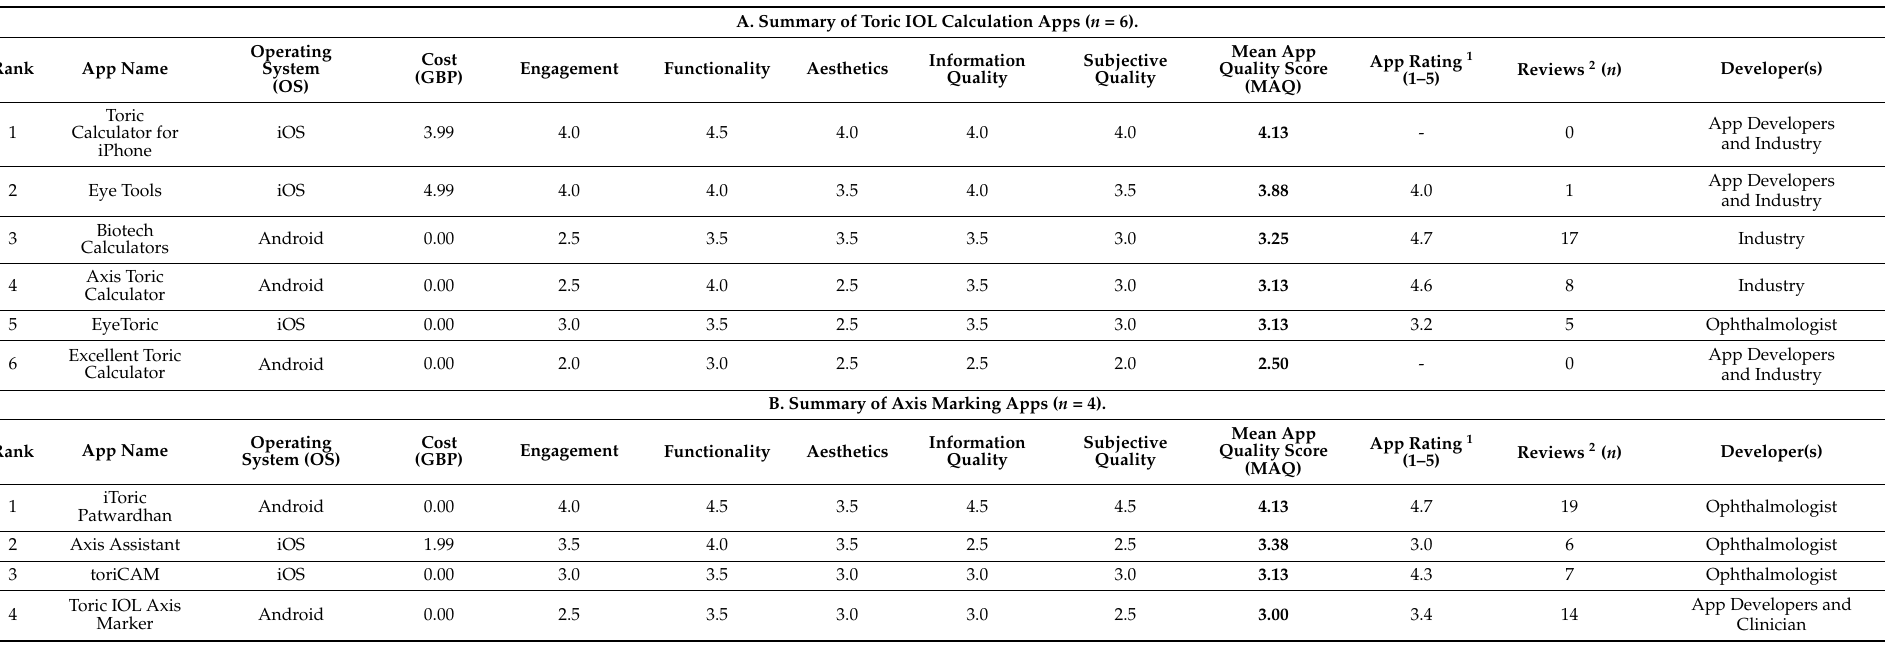
Table 3. Summary of toric IOL calculation apps ( n = 6) and summary of axis marking apps ( n = 4). A. Summary of Toric IOL Calculation Apps ( n =